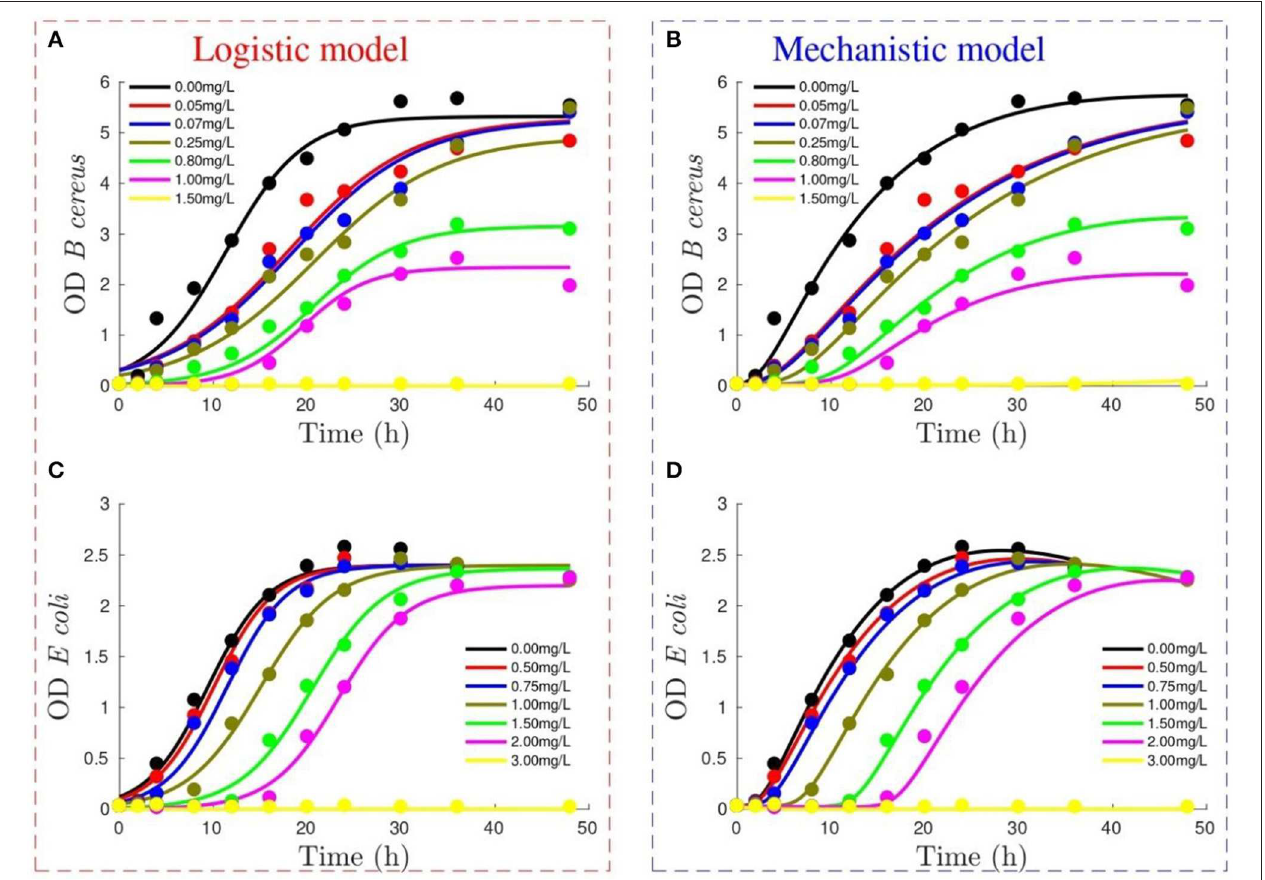
FIGURE 1 | Performance of logistic model (figures on the left) and mechanistic model (figures on the right) to reproduce optical density (OD) growth of Bacillus cereus (A,B) and Escherichia coli (C,D) at different Didecyldimethylammonium chloride (DDAC) concentrations (refer to legend). Lines show model output, whereas experimental data are represented by